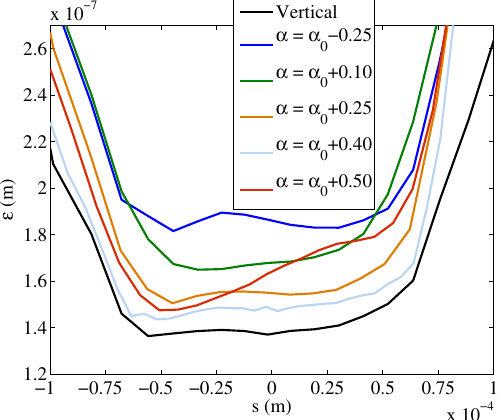
FIG. 16. Simulated horizontal slice emittance along the bunch for different beam optics along the bunch compressor. The compression factor is 15. The inset lists the horizontal α at the entrance of the bunch